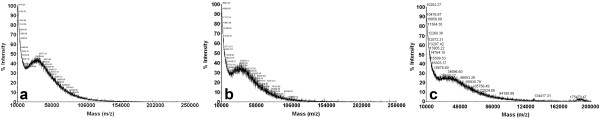
Mass spectra of PAA (a), LPG (b), and LPG-PAA conjugate (c) acquired from MALDI-TOF MS.